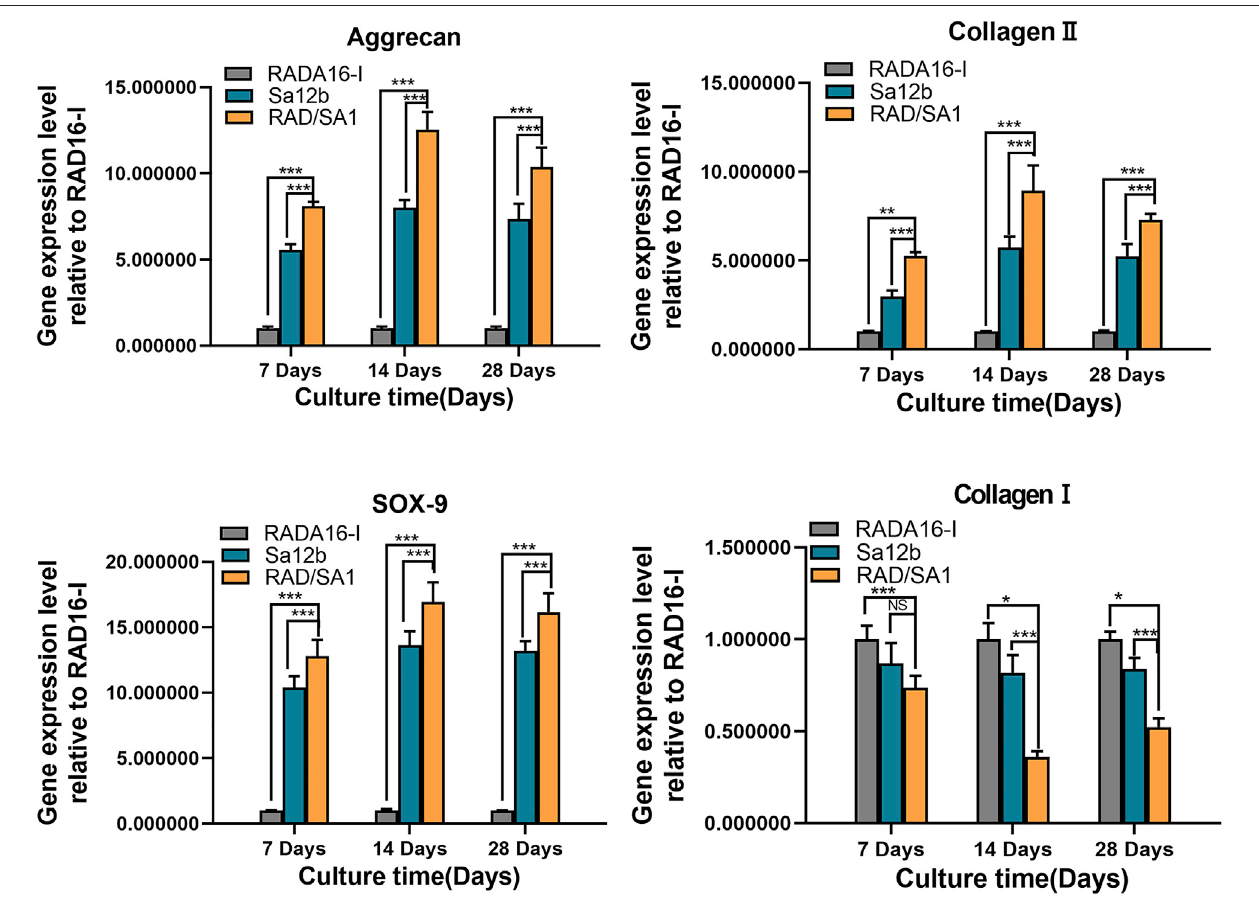
FIGURE 9 | QRT-PCR analysis revealed that the mRNA expression of collagen I, collagen II, aggrecan, and SOX-9 secreted by hNPMSCs were signi fi cantly different among the three groups ( pH = 6.8) after 7, 14 and 28 days, respectively.When the two groups compared, * indicates p < 0.05, ** indicates p < 0.01, and *** indicates p <